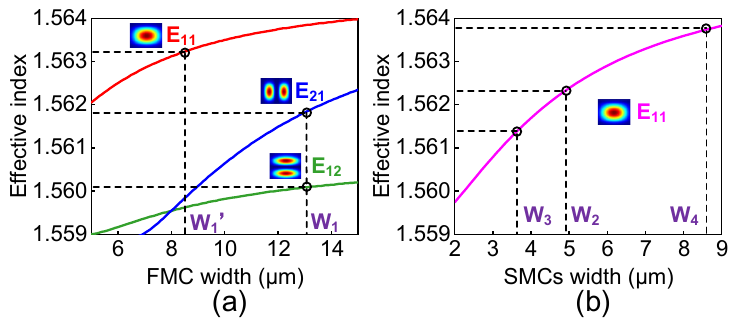
Figure 2. The variation of the effective indices of ( a ) the E 11 , E 21 and E 12 modes with the width of the FMC increasing and ( b ) the E 11 mode with the width of the SMCs